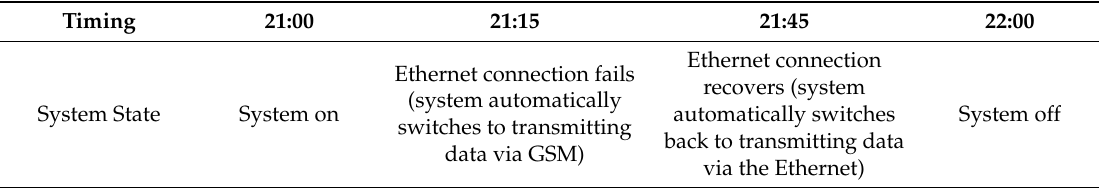
Table 2. Testing the functionality of the smart gateway.